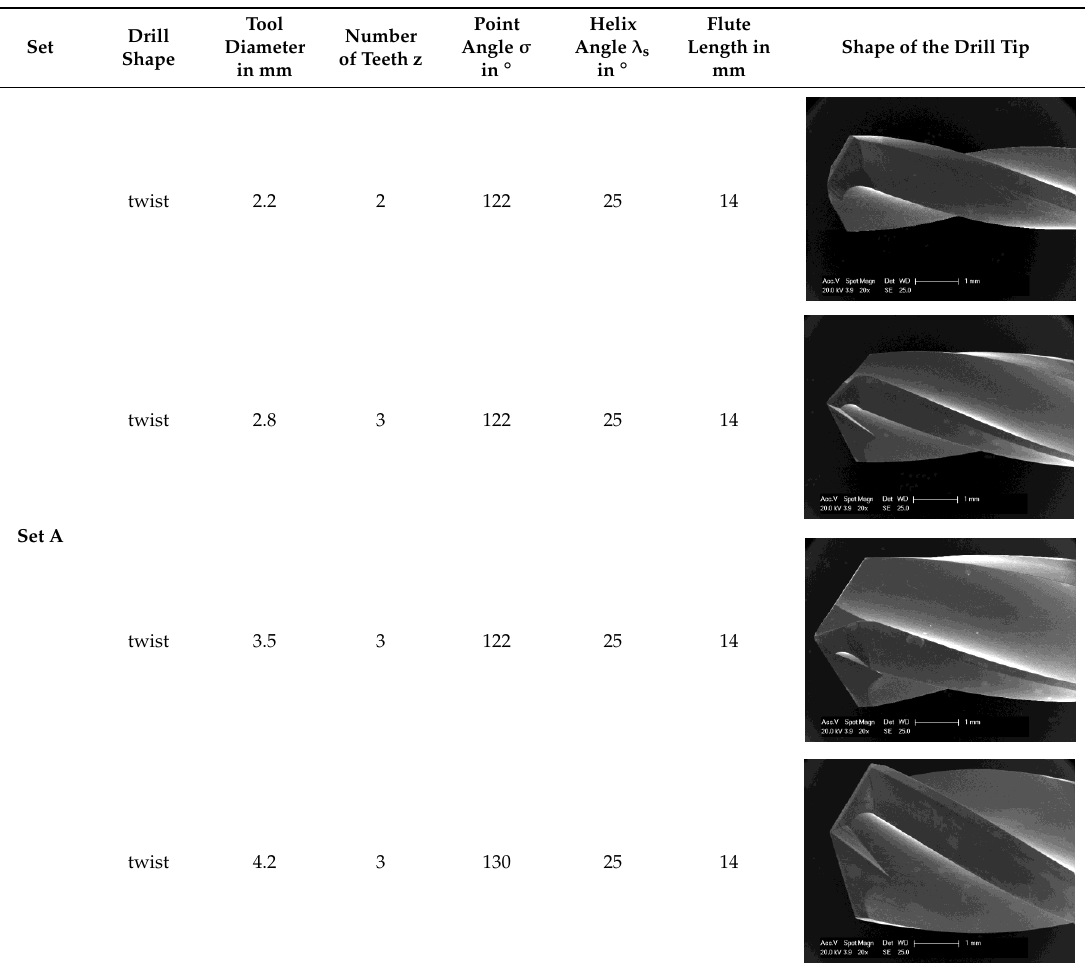
Table 2. Characterization of the drill geometry of five different drill sets (A–E).